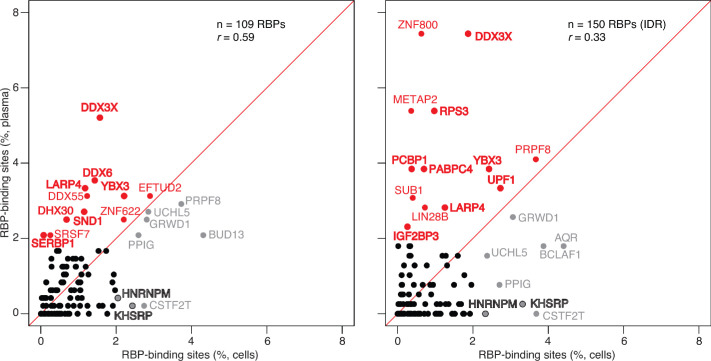
Scatter plot comparing the relative abundances of RBP-binding sites in plasma RNA peaks called against the human genome reference sequence with those of RBP-binding sites in ENCODE eCLIP cellular RNA datasets (ENCODE 109 RBP eCLIP dataset on the left and 150 RBP eCLIP dataset with irreproducible discovery rate (IDR) analysis on the right; the RBPs whose binding sites were searched are listed in the Supplementary file 1).Abundant RBP-binding sites enriched in plasma or cellular RNAs are indicated in red and gray, respectively. Stress granule proteins are indicated in bold. r is the Pearson correlation coefficient.